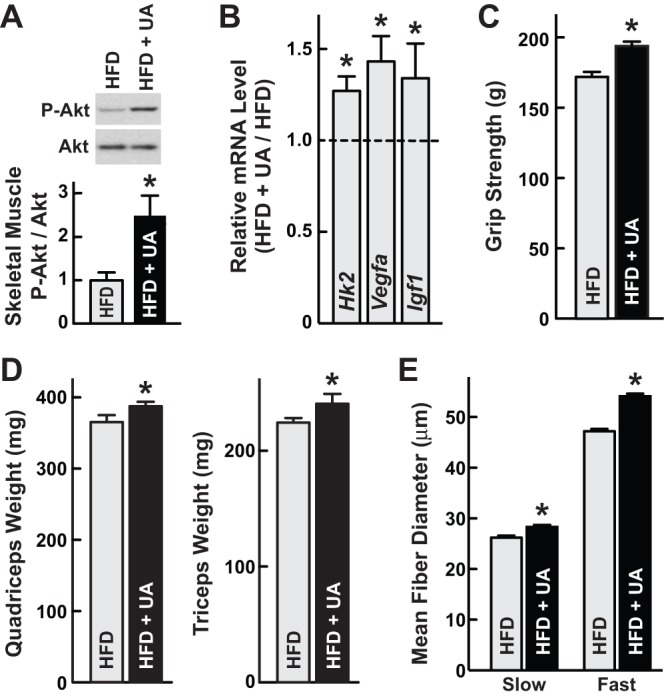
In mice fed a high fat diet, ursolic acid increases skeletal muscle Akt signaling, anabolic mRNA expression, grip strength, skeletal muscle mass, and fast and slow skeletal muscle fiber size.Mice were provided ad libitum access to high fat diet (HFD) lacking or containing 0.14% ursolic acid (UA) for 6 weeks. Data are means ± SEM. *P<0.05 by t-test. (A) Triceps muscles here harvested and subjected to SDS-PAGE and immunoblot analysis with anti-phospho(Ser473)-Akt and anti-Akt antibodies. Upper: representative immunoblots. Lower: Phospho-Akt (P-Akt) and total Akt levels were quantitated with densitometry. In each mouse, the phospho-Akt/total Akt ratio was normalized to the average phospho-Akt/total Akt ratio in mice fed HFD lacking UA. n = 5 mice per diet. (B) Quadriceps mRNA levels were determined using qualitative real-time RT-PCR (qPCR). Levels in UA-treated mice were normalized to the average levels in mice fed HFD lacking ursolic acid, which were set at 1. n = 10 mice per diet. (C) Grip strength. n = 10 mice per diet. (D) Weights of bilateral quadriceps and triceps brachii (triceps). n≥12 mice per diet. (E) Slow and fast muscle fiber diameters. Sections of triceps muscle were subjected to immunohistochemical analysis with anti-slow myosin and anti-fast myosin antibodies, and then fiber diameter was measured. Slow fibers: n≥50 fibers/triceps from 5 mice per condition. Fast fibers: n≥100 fibers/triceps from 5 triceps per condition.